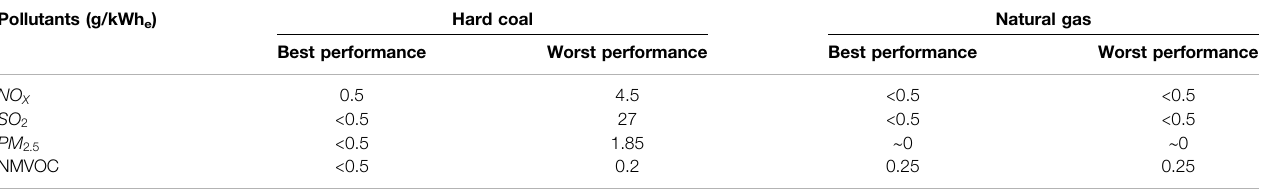
TABLE 1 | Various emissions from coal and natural gas power